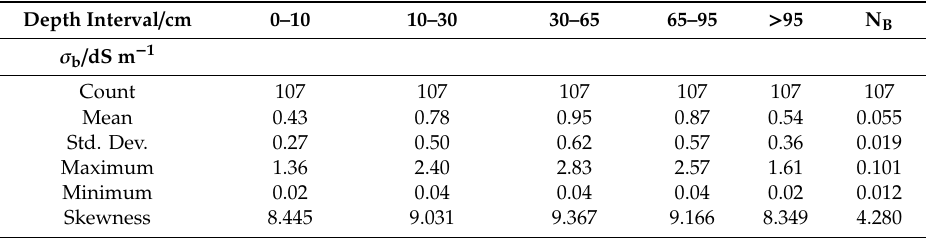
Table 6. Statistical summary of the soil bulk electrical conductivity at di ff erent soil depth intervals estimated by inversion of Equation (6) in the soils of the study area using the Tikhonov regularization and the induction numbers ( N B ) calculated using Equation